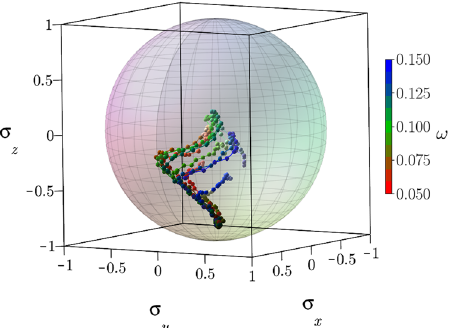
Fig. 4 Single-qubit state trajectories with respect to simulated time for a range of frequencies. Scan of several trajectories represented in the Bloch sphere for a single-qubit device for a range of frequencies ω ∈ [0.05, 0.15] in increments of 0.01, from ibmq_armonk. σ i represents the expectation Fig. 5 Simulated time evolution of a two-qubit local system which with respect to that operator as a function of time. Each simulation has an demonstrates state transitions on local sites. Populations n ij where equal number of gate applications and changes only the frequency ω in the i , j ∈ {0, 1}, referring to the eigenstates of the two-qubit system undergoing (cid:3) . ω decreases from propagation with time step τ , exp ½(cid:2) i τ H (cid:3) ¼ exp ½(cid:2) i ωσ z 3 simulated evolution for time t with time step τ = 1/3 prepared on red ( ω = 0.05) to green ( ω = 0.10) to blue ( ω = 0.15). ibmq_rome. The system Hamiltonian can be described with two